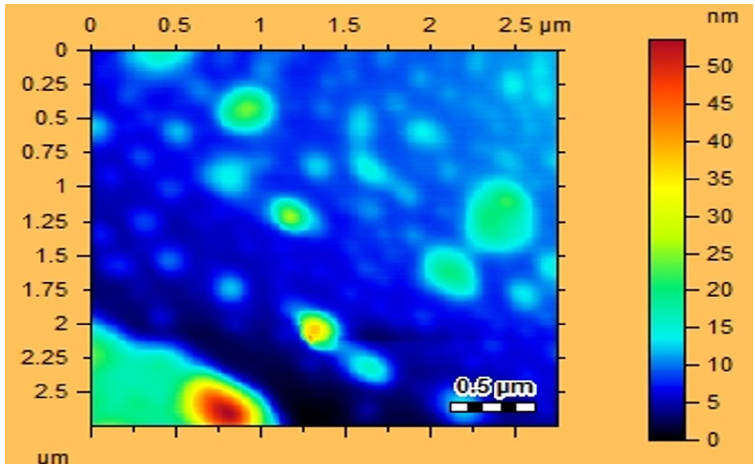
Fig. 5. AFM analysis of D. salicifolia silver nanoparticles.